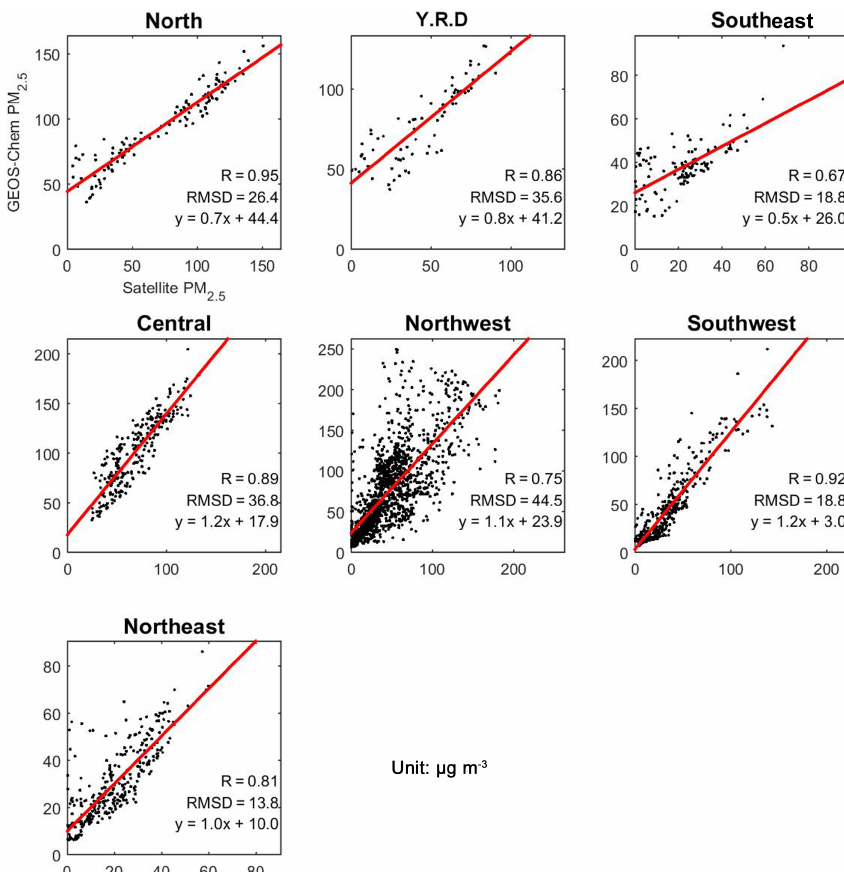
Figure 6. Comparisons between the simulated and satellite-derived PM 2 . 5 concentrations over the seven China